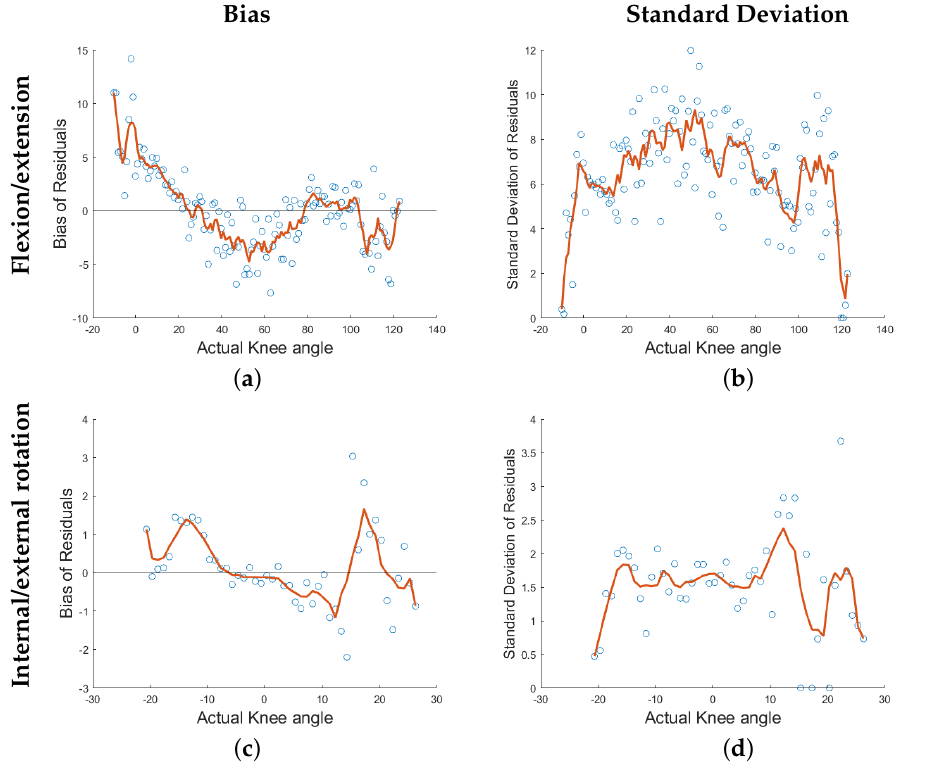
Figure 8. Distributions of all subjects’ bias and standard deviations in both degrees of freedom. Blue dots represent the local average across all subjects within 2 degree ranges. Lines represent the average of all